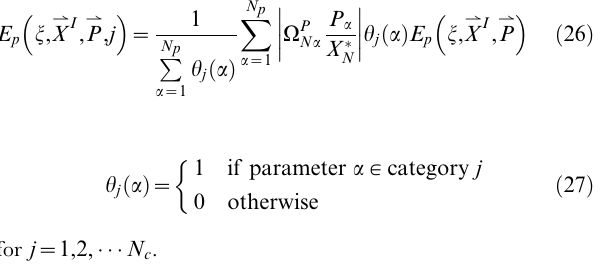
Figure S1 Distribution of the topologies with different fractions of TR networks, F succ . Linear regression results for 3-node topologies (A): slopes =0.63, 0.59, 0.53, 0.52, 0.67, and r= 0.67, 0.52, 0.65, 0.67, 0.54 for F succ , 0.8%, 0.8% # F succ , 2.3%,